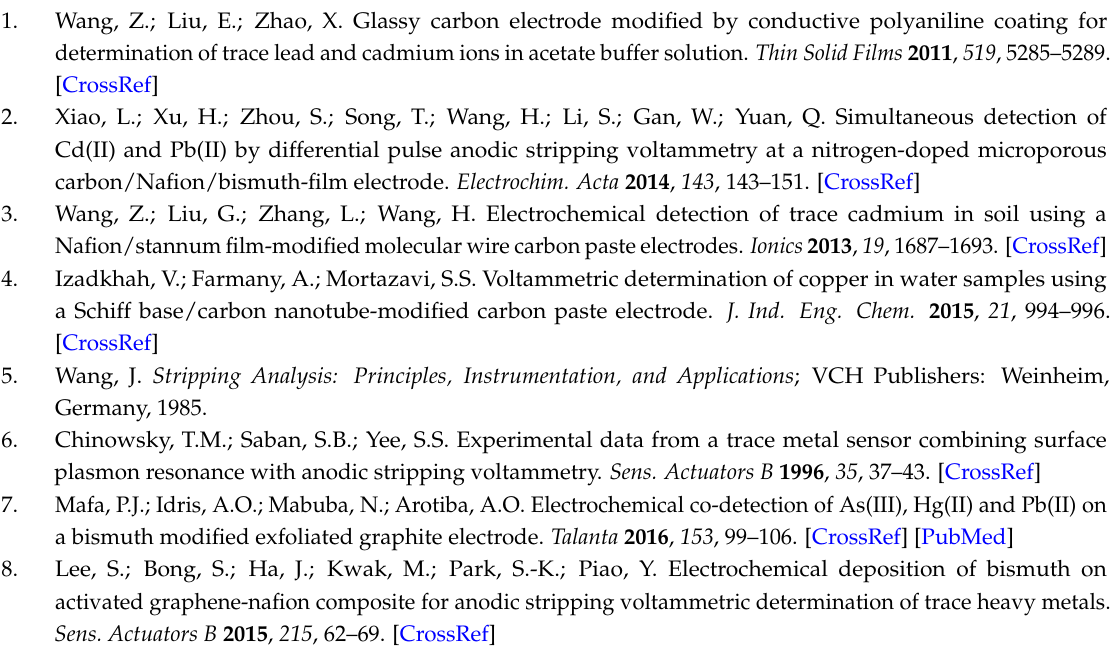
s1, Table S1: Experimental design and results of the training dataset, Table S2: Experimental design and results of the testing